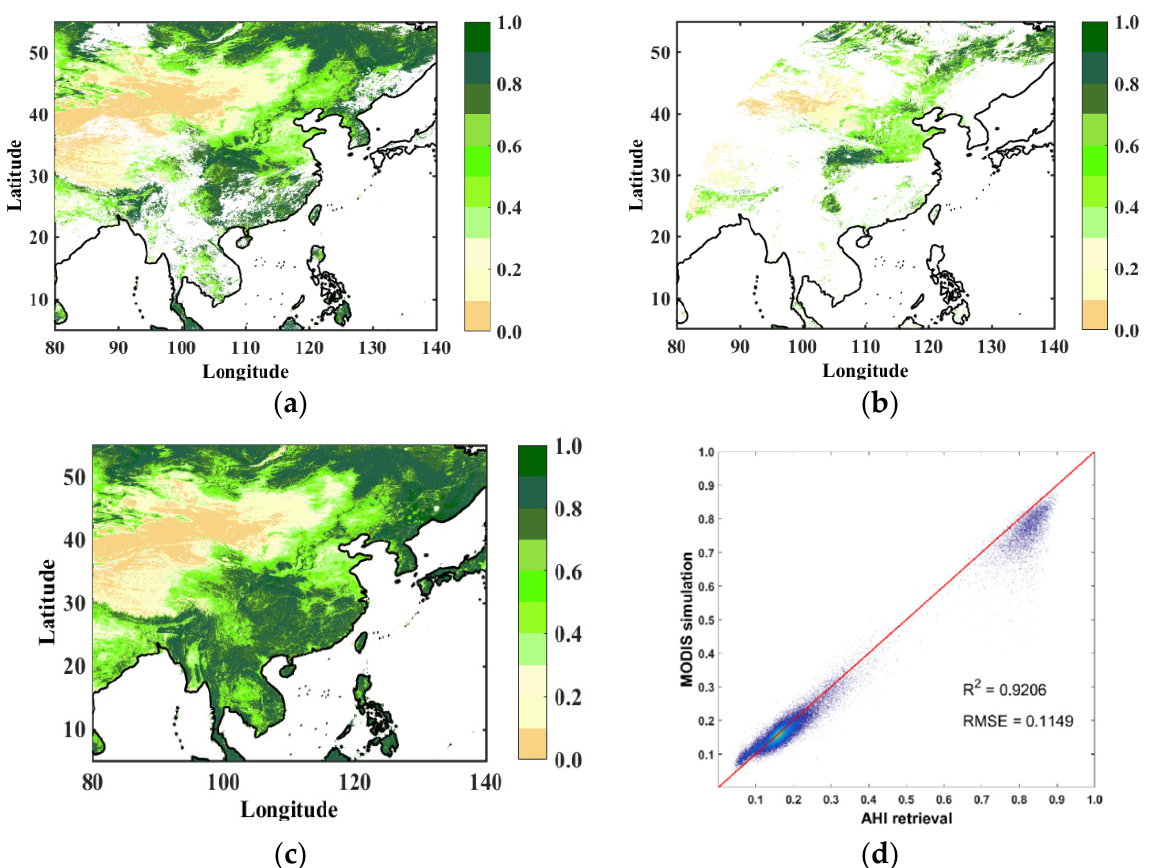
Figure 11. ( a ) Composite NDVI products from ( a ) one day of AHI data, ( b ) a single time (00:00 UTC on 1 July 2019) NDVI, ( c ) composite NDVI products from 16 days MODIS and ( d ) a comparison of the AHI one day and MODIS 16 days.